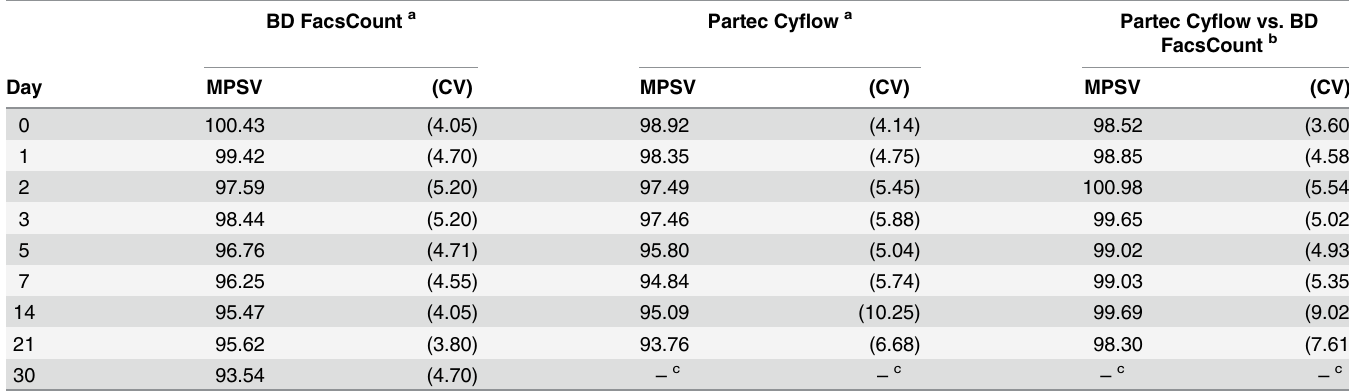
Table 4. Similarity of BD Vacutainer CD4 Stabilization Tube sample results on BD FacsCount and Partec Cyflow over